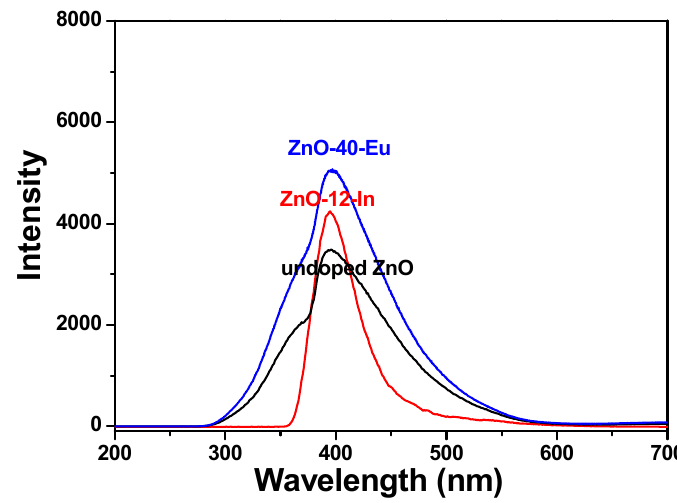
Figure 8. Photoluminescence emission (PL) spectra of 100 °C-grown ZnO, 60 °C-grown ZnO-40-Eu, and 88 °C-grown ZnO-4-In nanowires.